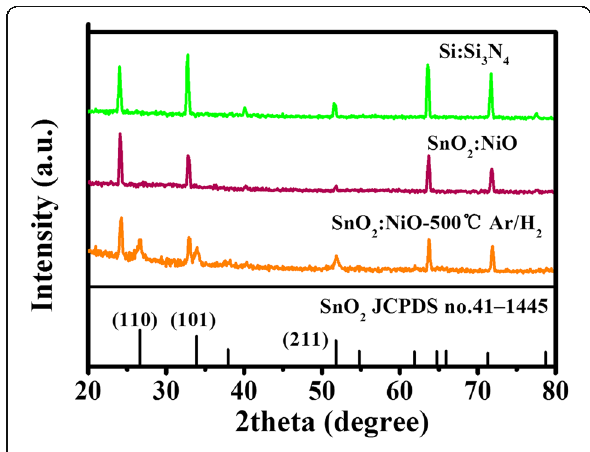
Fig. 4 The SAXS characterization of the Si/Si 3 N 4 substrate, the as- deposited SnO 2 :NiO film, and the SnO 2 :NiO film annealed at 500